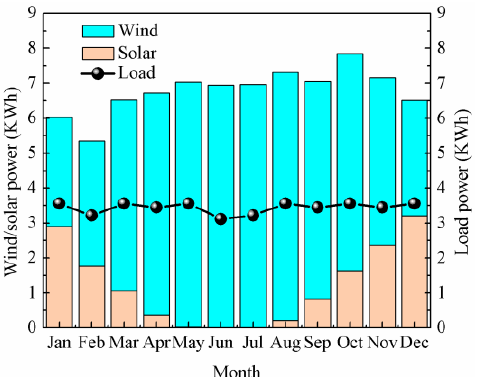
Figure 17. Monthly average PV and WT energy power production and load demand of the observing system in Zhongshan Station, Antarctica.